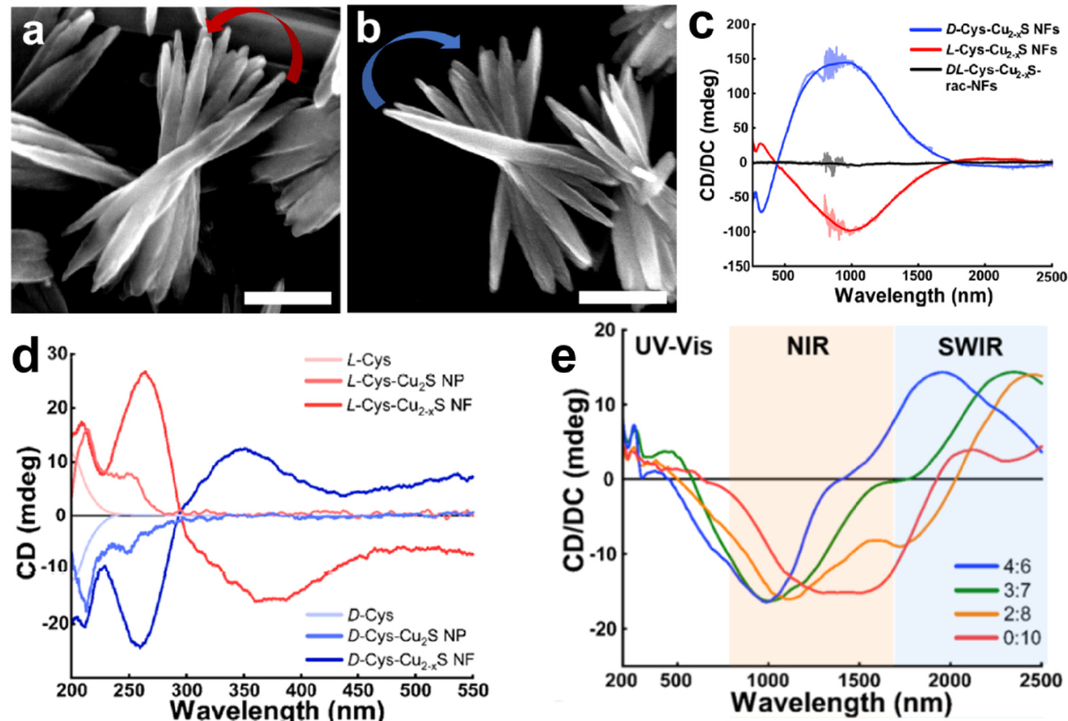
Figure 12. SEM images of ( a ) L- Cys-Cu 2 − x S NFs and ( b ) D- Cys-Cu 2 − x S NFs, scale bar = 500 nm. ( c ) CD spectra of thin films of NFs on a quartz wafer. ( d ) CD spectra demonstrating chirality transfer from L- / D- cysteine to the corresponding NFs. ( e ) CD spectra of chiral NFs with different chiral ligand and molar ratios (thioglycolic acid: L- cysteine). Reprinted with permission from Ref. [28] . Copyright 2021 American Chemical Society.